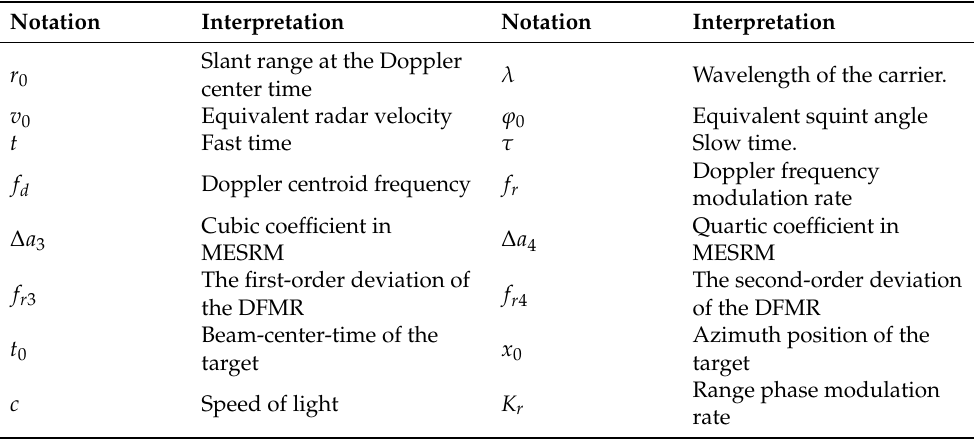
Table 2. The mathematical notations.